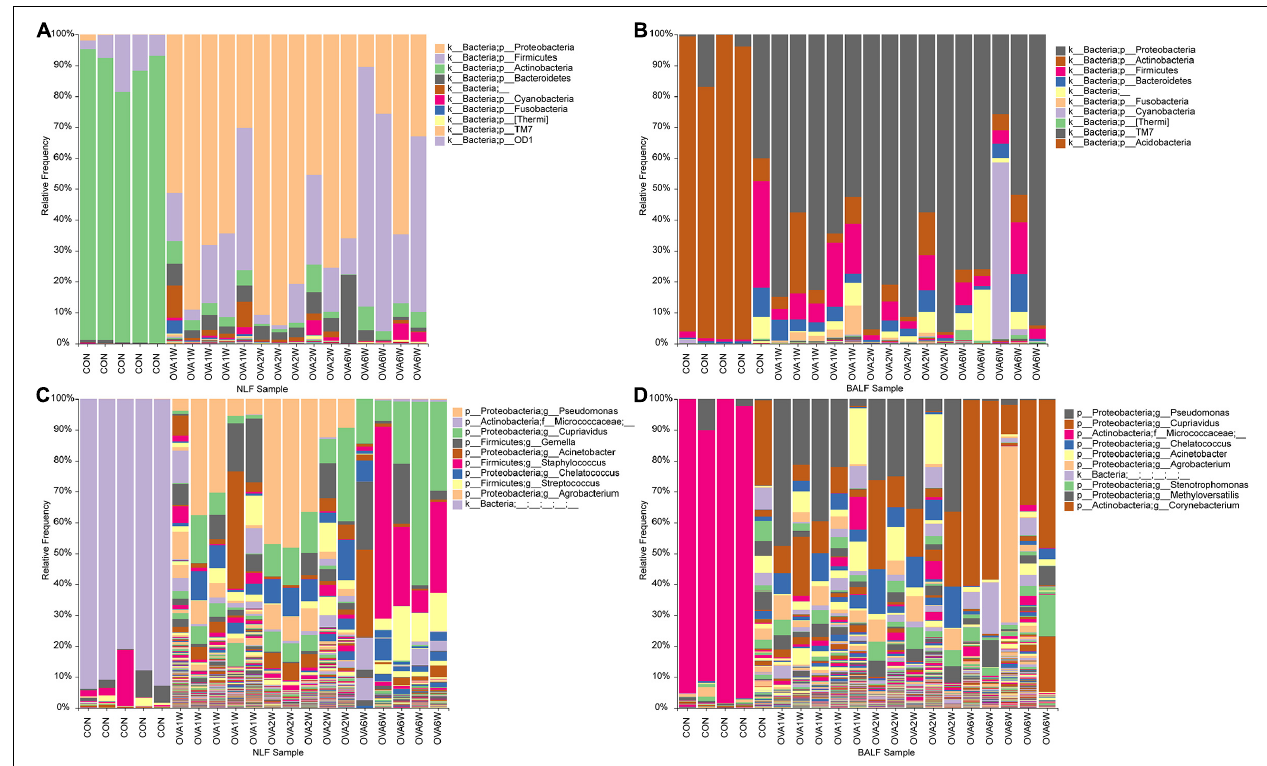
FIGURE 4 | Microbial composition in the URT and LRT at the phylum and genus levels. (A) The composition of URT microbiota (NLF samples) at the phylum level. (B) The composition of LRT microbiota (BALF samples) at the phylum level. (C) The composition of URT microbiota (NLF samples) at the genus level. (D) The composition of the LRT microbiota (BALF samples) at the genus level ( n = 5 in each group; only the top 10 legends with high abundance are